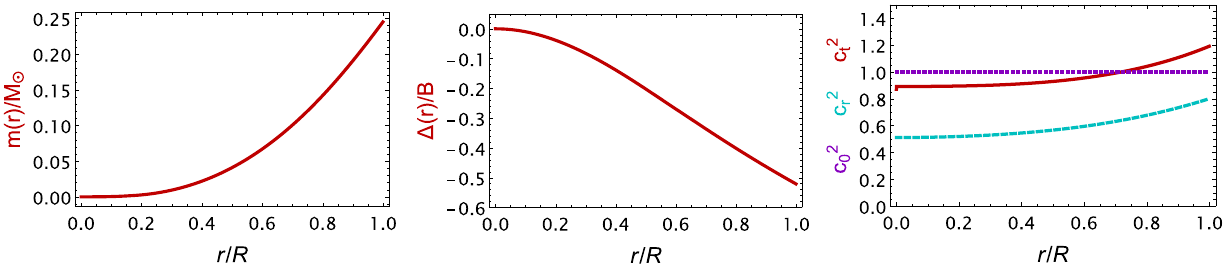
Fig. 4 Anisotropic DE stars considering a more standard approach and assuming small a : Mass function in solar masses (left panel), anisotropic factor (middle panel), and sound speeds (right panel) versus radial coordinate throughout the